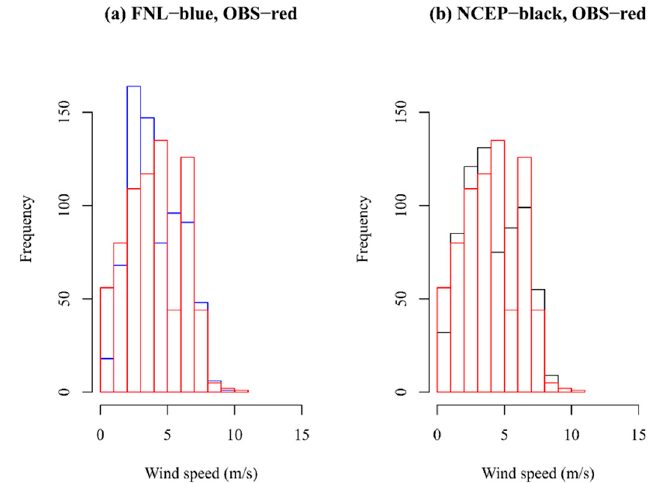
Figure 11. Histograms of 10 m level wind speed at Piarco simulated by WRF using FNL as input atmospheric conditions (in blue), with NCEP as input (in black) as compared against in-situ observations (in red).